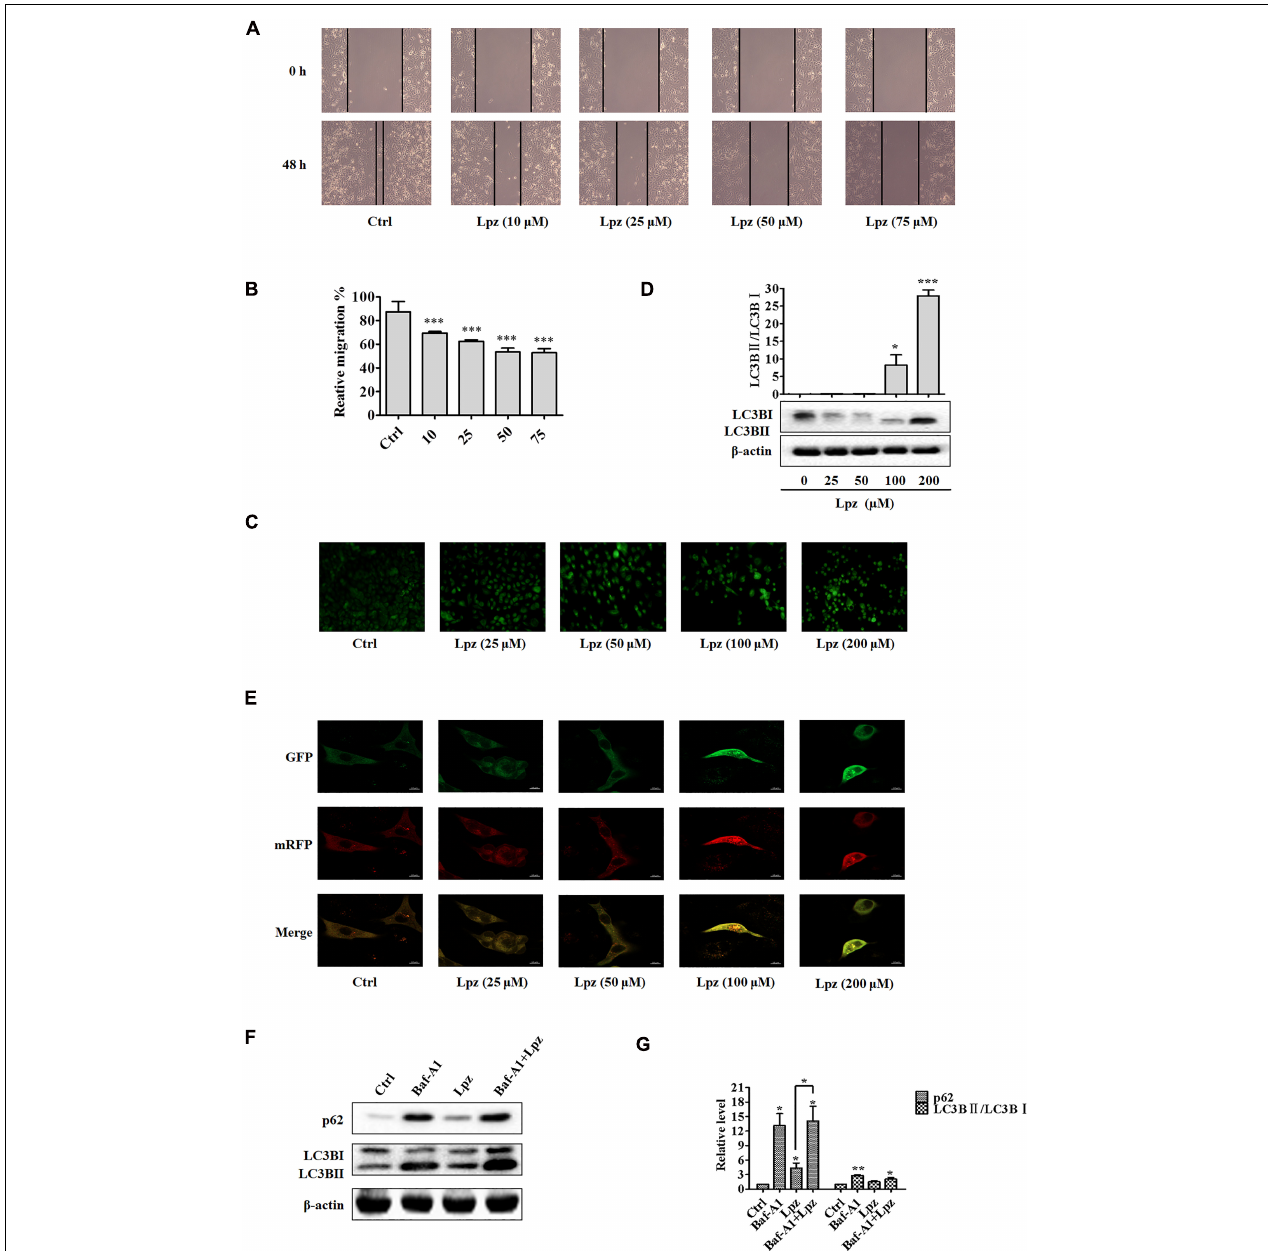
FIGURE 2 | Lansoprazole inhibits migration and autophagy in A549 cells. (A) Representative images depicting the wound healing ability of A549 cells with or without Lpz treatment. (B) Quantification of the results in panel (A) . (C) Observation of autophagic vesicle formation by MDC staining. (D) Western blot analysis of the levels of LC3B in the absence or presence of Lpz. (E) Lpz suppresses autophagic flux in A549 cells. (F) Western blot analysis of the levels of p62 and LC3B in the presence of Lpz or Baf-A1 alone or in combination. (G) Quantification of the results in panel (F) . Data shown are the mean ± SD of three independent experiments. *: p < 0.05, **: p < 0.01, and ***: p < 0.001.